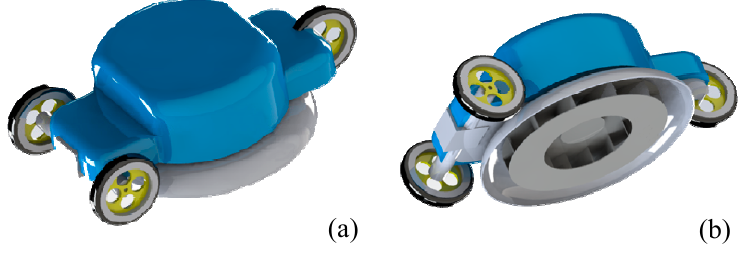
Figure 2. The WMR 3D model. WMR top ( a ) and bottom ( b ).